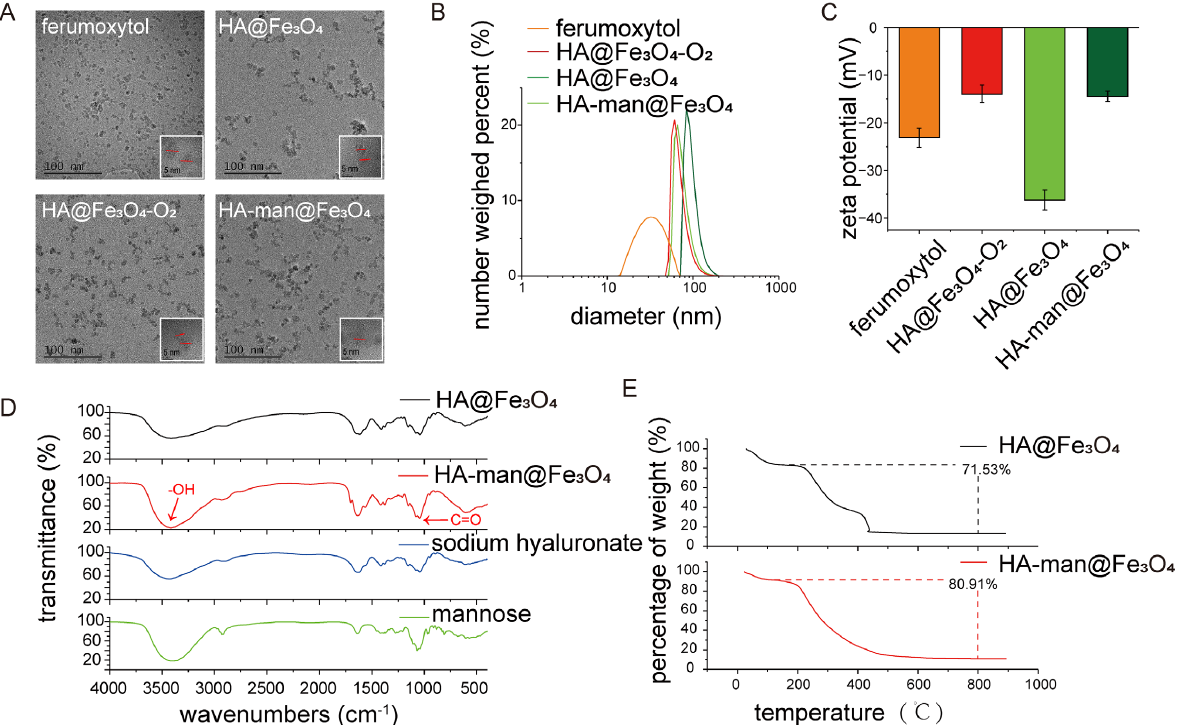
Figure 1. Characterization of iron oxides. ( A ) Transmission electron microscope (TEM) images of feru-